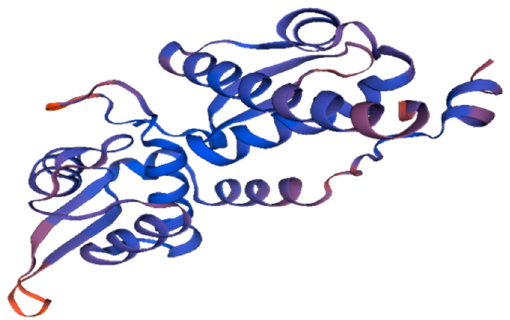
Figure 1. The 3D Structure of MAGE-A build using Swiss Model.